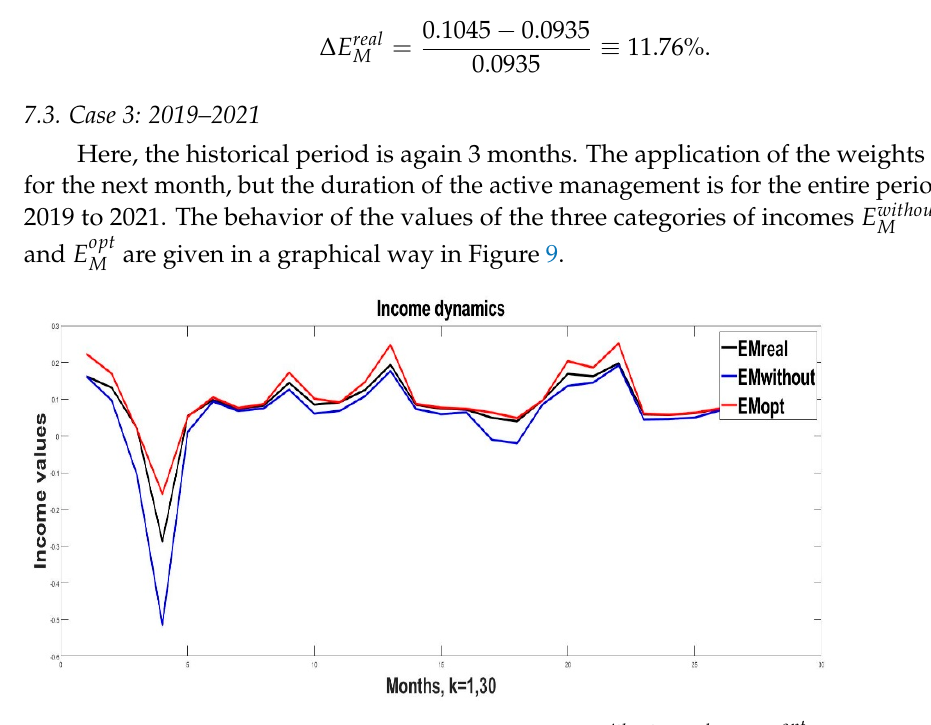
, E real , and E opt M M M